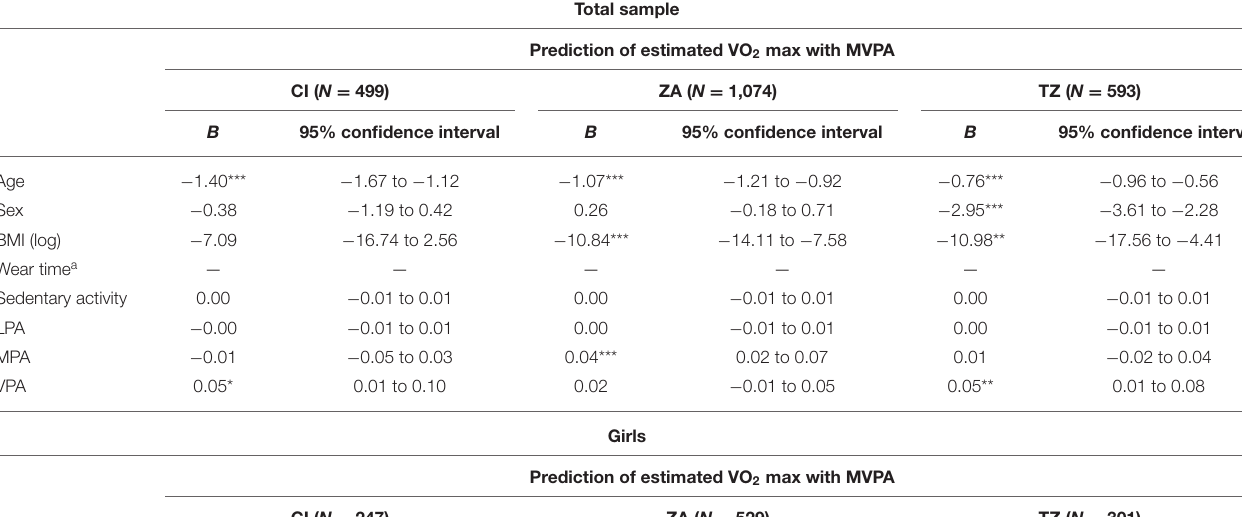
TABLE 6 | Association between physical activities with different intensities and children’s cardiorespiratory fitness in Côte d’Ivoire (CI), South Africa (ZA), and Tanzania